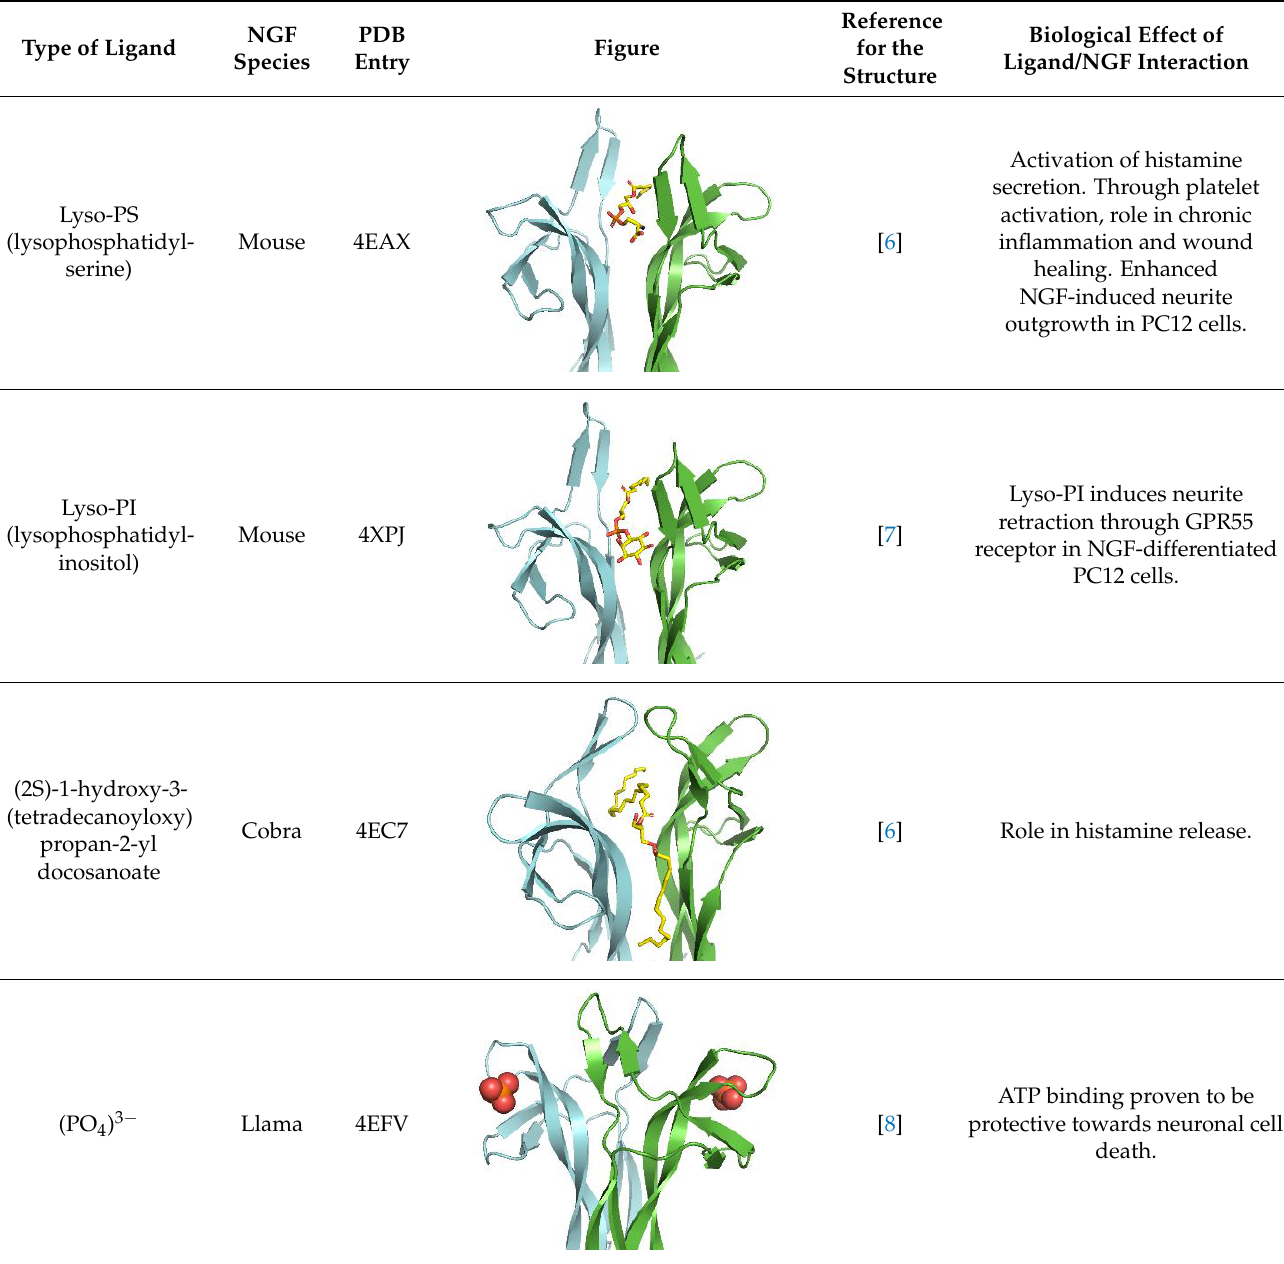
Refer- ence for Biological Effect of Ligand/NGF Interac- the Struc- ture